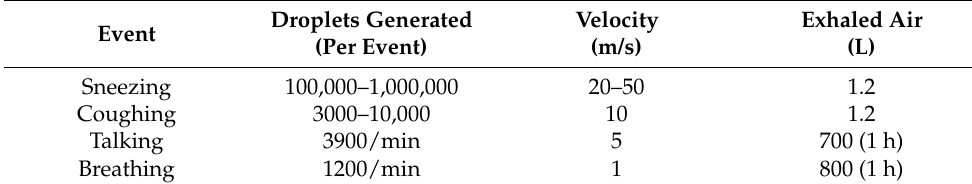
Table 1. Average emission per person and event [8].